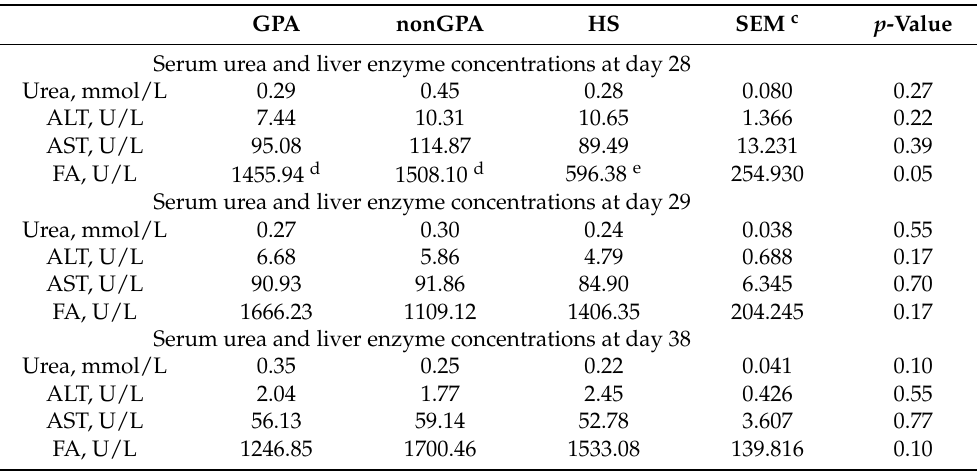
Table 3. Effect of the type of growth promoter on the serum urea and liver enzyme concentrations at 28, 29, and 38 days a,b